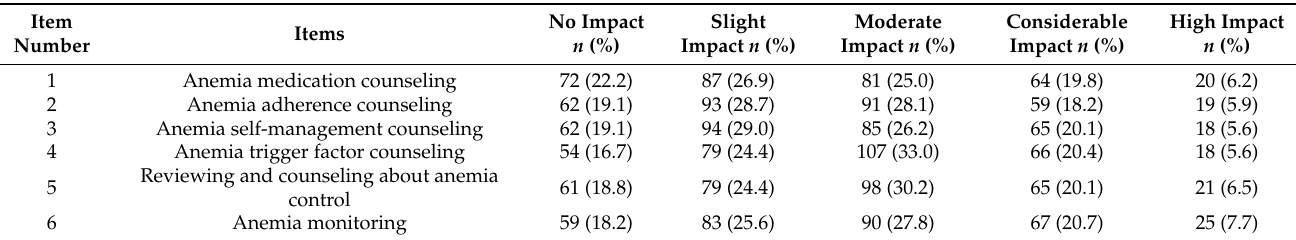
Table 6. Lack of confidence or skills.